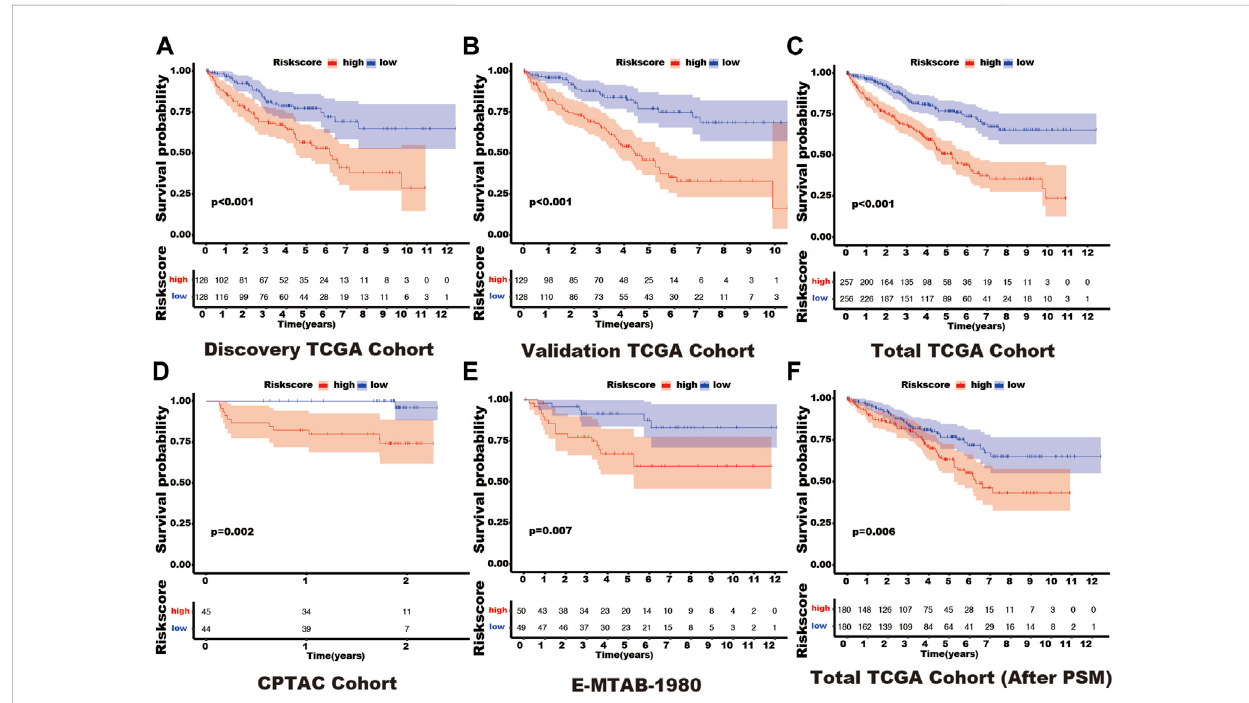
FIGURE 2 The different outcomes in various SUMOylation risk groups. In each fi gure, the red line represents the outcome of patients in the high SUMOylation risk group, the blue line shows the outcome of patients in the low SUMOylation risk group, and the box shows the live patient count during the entire follow-up period. Log-rank analysis was used to compare the outcomes of patients in different risk groups and presented by the Kaplan-Meier curve. (A) Discovery TCGA cohort. (B) Validation TCGA cohort. (C) Total TCGA cohort. (D) CPTAC cohort. (E) E-MTAB-1980 cohort. (F) Total TCGA cohort (After PSM). Propensity-matched analysis: